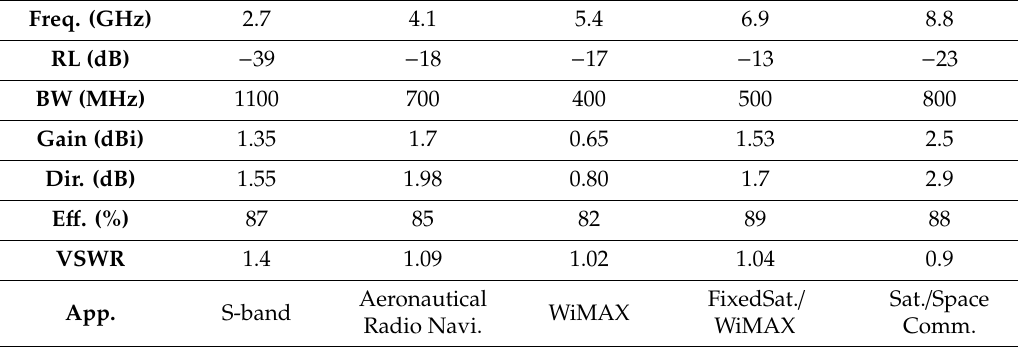
Table 5. Summarized results of Case